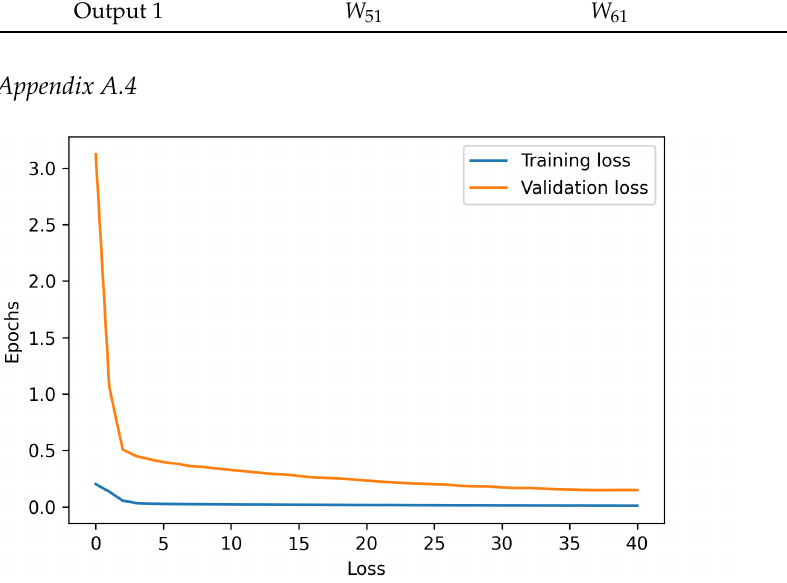
Figure A1. Training and validation losses during the training of LSTM auto-encoder.